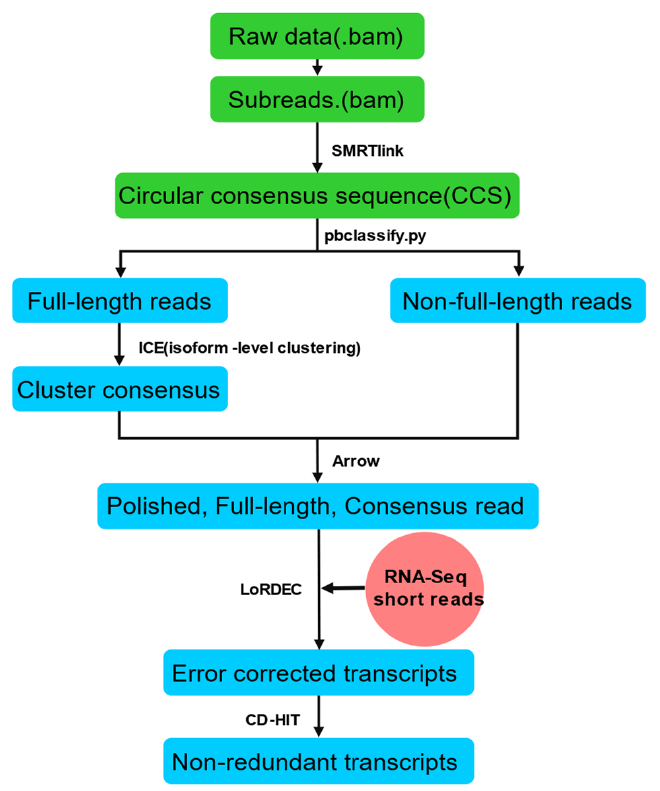
Figure 9. Analysis pipeline for SMRT-Seq data.